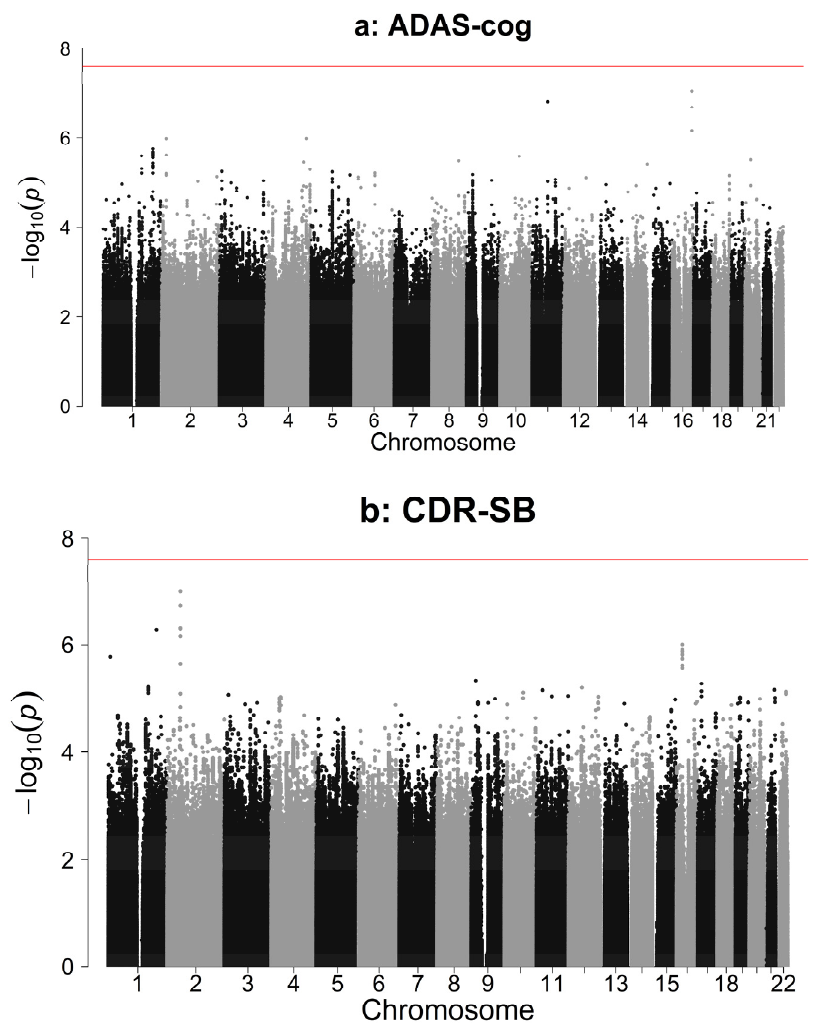
Figure 1. Manhattan plots showing Genome-Wide Association Study (GWAS) results for two cognitive decline endpoints. Red line: GWAS significance threshold of p < 2.5 × 10 -8.